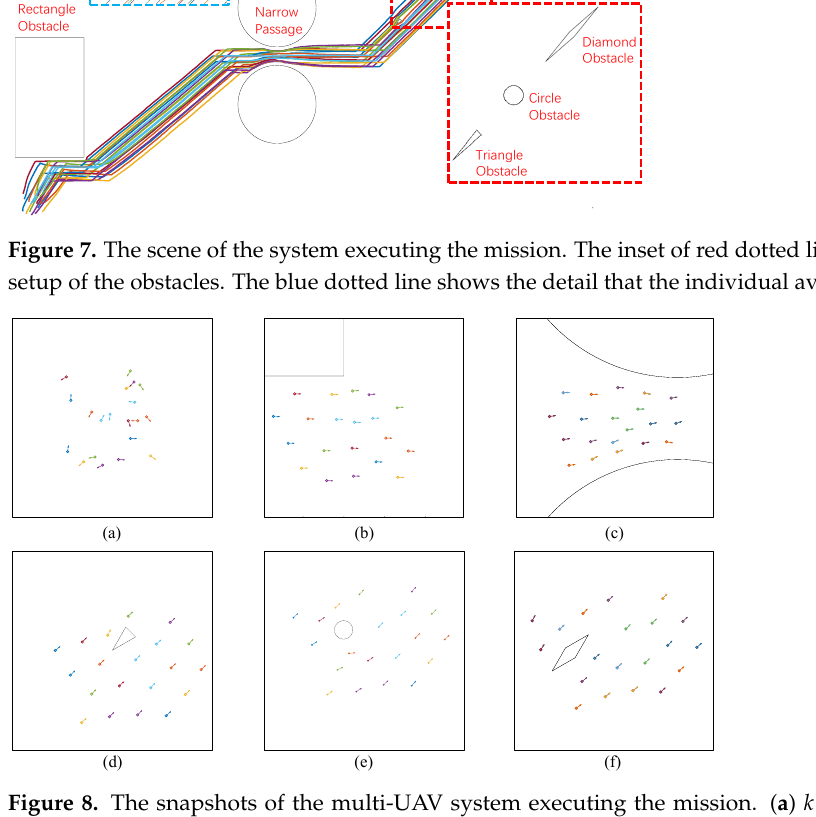
Figure 8. The snapshots of the multi-UAV system executing the mission. ( a ) k = 1; ( b ) k = 80; ( c ) k = 320; ( d ) k = 485; ( e ) k = 560; ( f ) k =